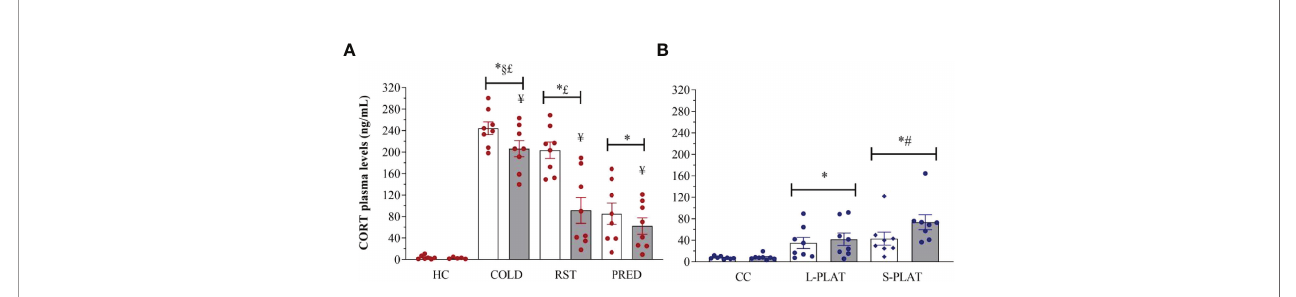
FIGURE 7 | (A) Effect of different stressors and (B) of PSD on corticosterone plasma levels. Data were plotted with individual values and the columns represent the mean ± SEM of 13 animals/subgroup. HC, home cage; RST, restraint stress; PRED, predator odour; CC, container control; L-PLAT, large platform; S-PLAT, small platform. White columns represent single or 1-day exposure and grey columns, repeated or 4-day exposure. * = different from respective control group; § = different from RST group; £ = different from PRED group; # = different from L-PLAT group; ¥ - different from single or from 1-day exposure.